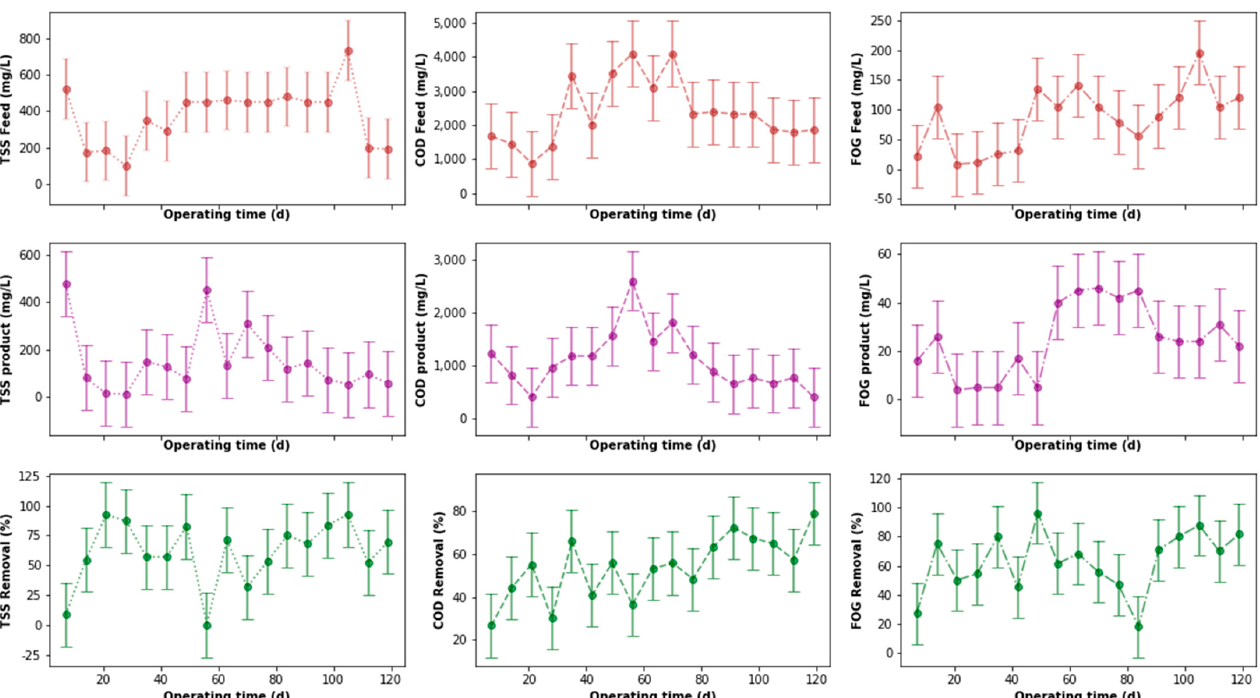
Figure 8. EGSB Treatment performance before anomaly detection and correction.